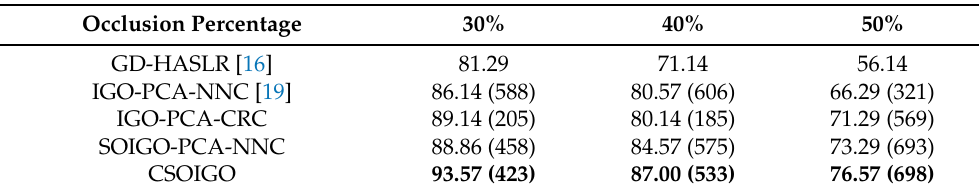
Figure 6. Original face image and its occluded images with different occlusion percentages; from the second to the last, the percentage is 30%, 40%, and 50%, respectively. Table 5. Recognition accuracy (%) of competing methods under different percentages of occlusion on a subset of the AR database (original training and test samples have no sunglasses occlusion or scarf occlusion). The dimension that leads to the best result for IGO- and SOIGO-based approaches is given in